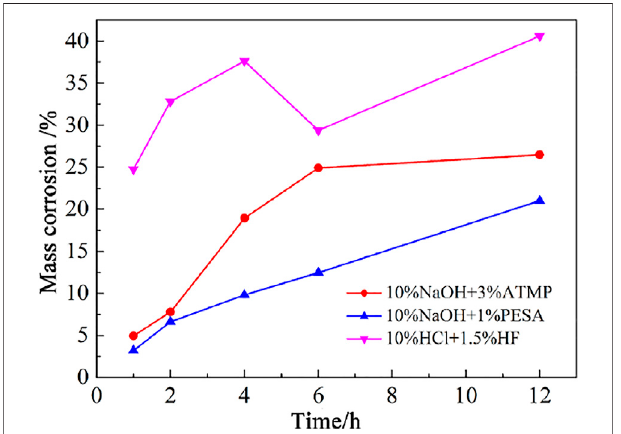
FIGURE 7 | Change of the mass corrosion rate of rock powder.